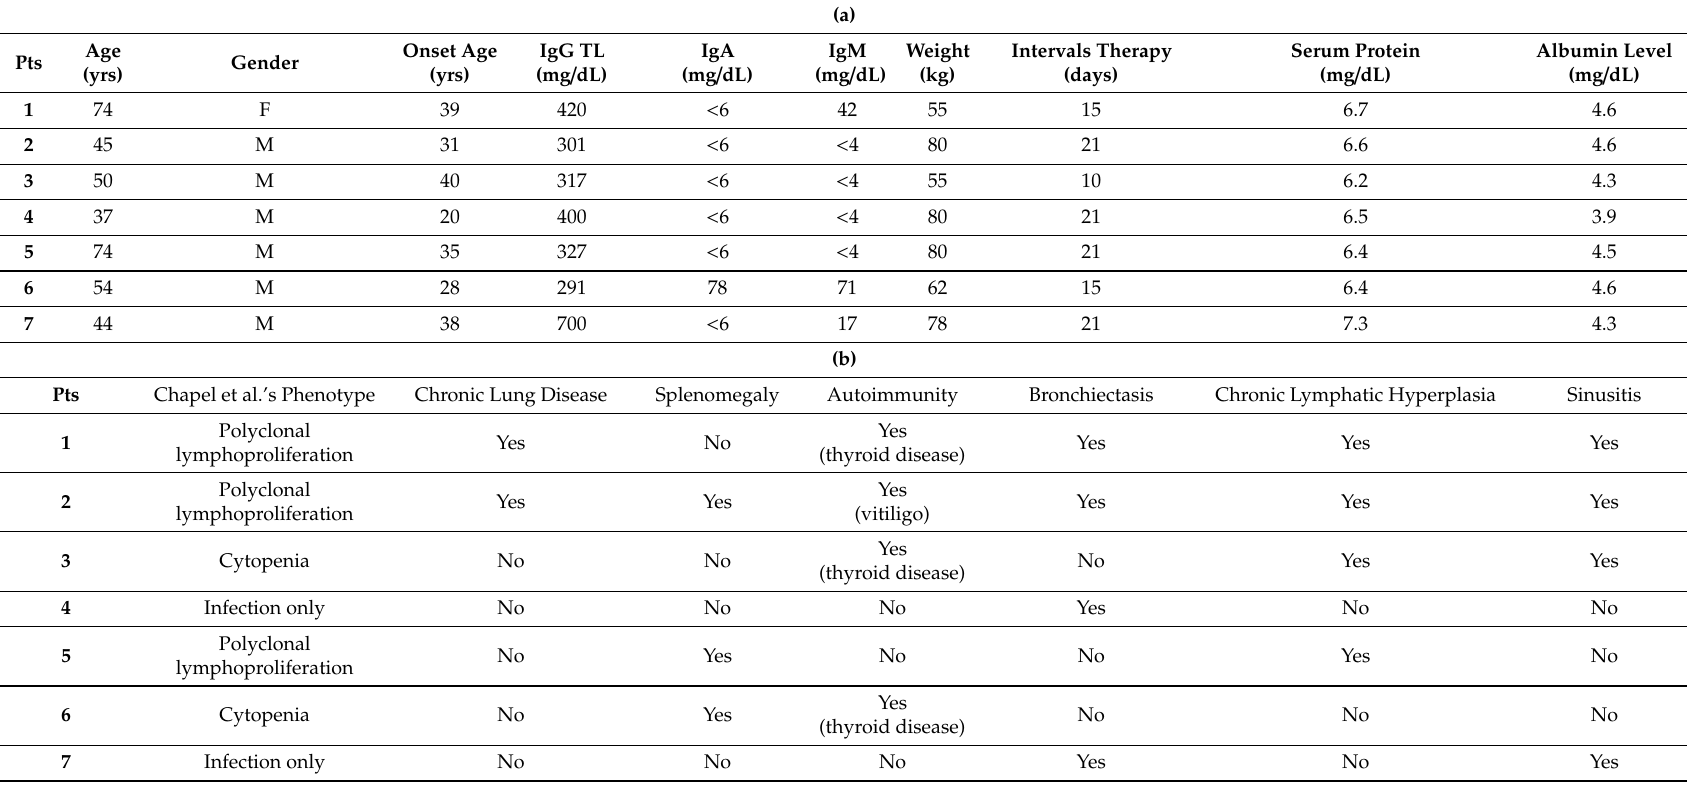
Table 1. ( a ) Immunological and ( b ) clinical data of seven common variable immunodeficiency (CVID) patients.